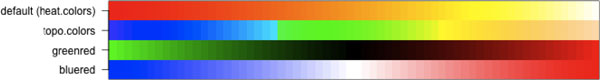
Color palettes. A selection of pre-defined color palettes available in R.